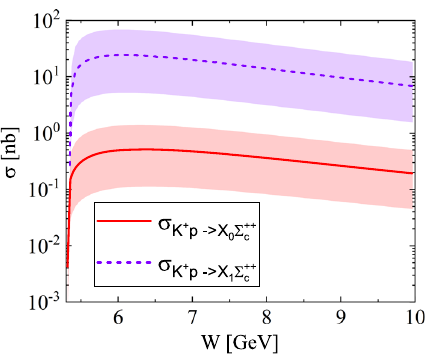
Fig. 2 The energy dependence of the total cross section for the pro- ductions of the X 0 and X 1 in K + p collisions with α = 1 . 5 ± 0 . 5 GeV. The red solid and violet dashed lines are for the productions of X 0 and X 1 , respectively. The bands stand for the error bar of the cutoff